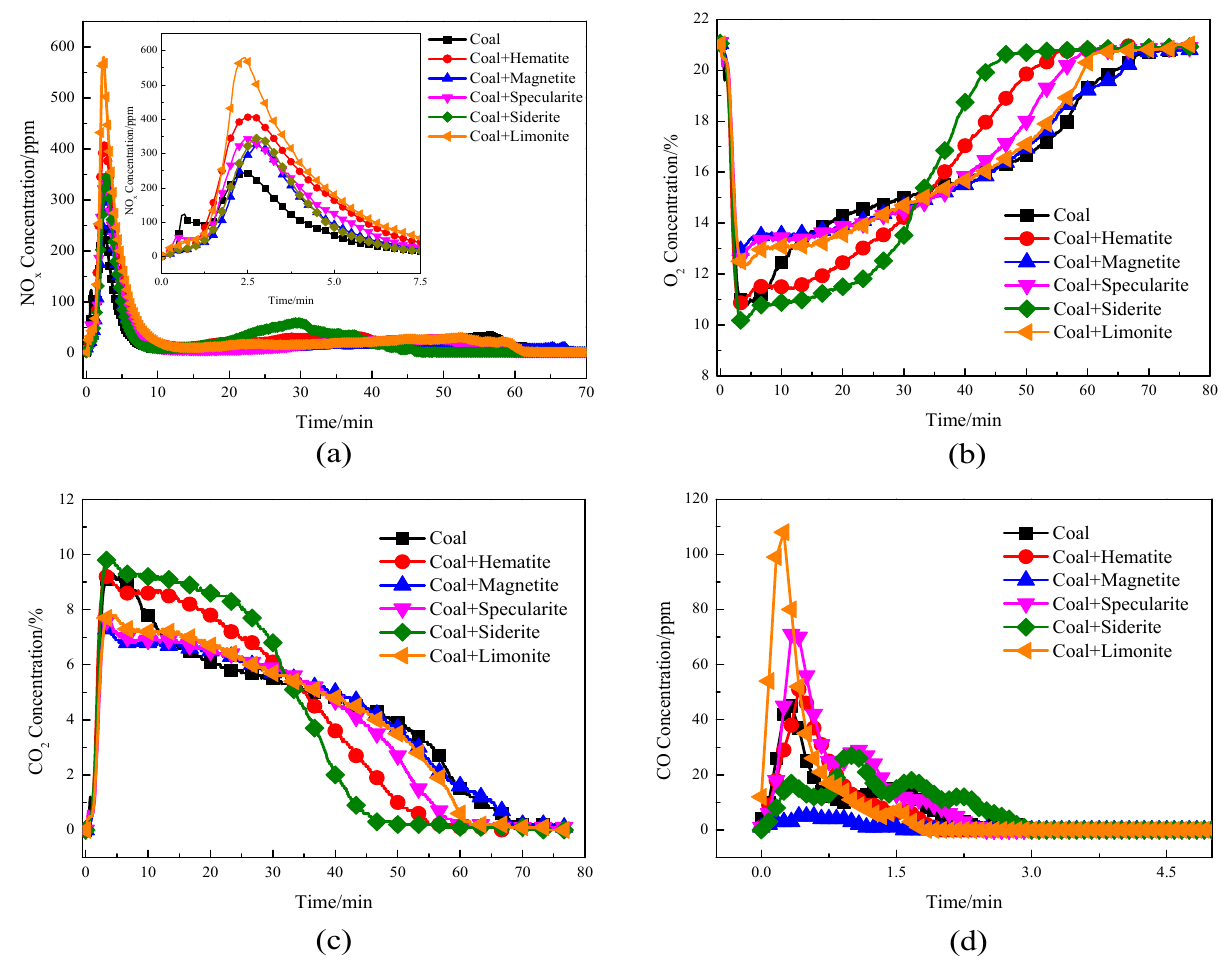
Figure 6. Influence of iron-bearing pure minerals on the variation law for flue gas composition in pulverized coal combustion: ( a ) NO x concentration, ( b ) O 2 concentration, ( c ) CO 2 concentration, ( d ) CO concentration.